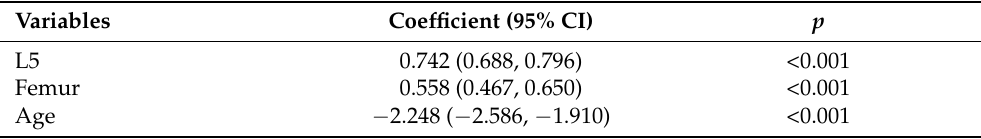
Table 2. Linear regression analysis between T12 bone densities and L5 bone densities, Femur bone densities, and age.